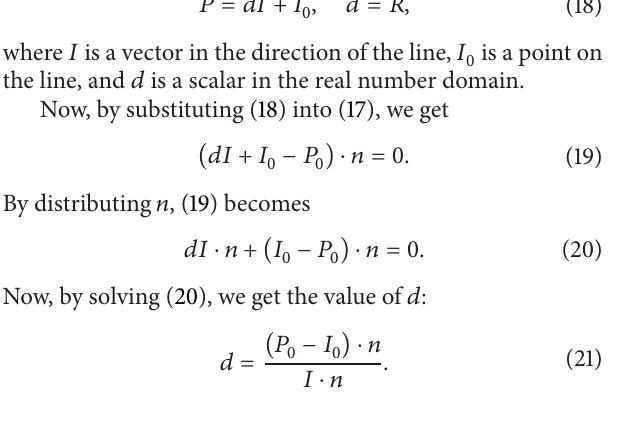
the coordinate of 𝐴 . These points will be used for cal- culating the distance between the objects and ray source point (𝑋 2 , 𝑌 2 ) . This will be done by using the “Pythagoras